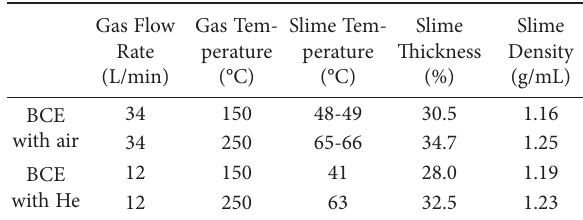
Table 1. De-watering of initial 20% silica slime (density of 1.05 g/ mL) using BCE process with different gases (air and helium).